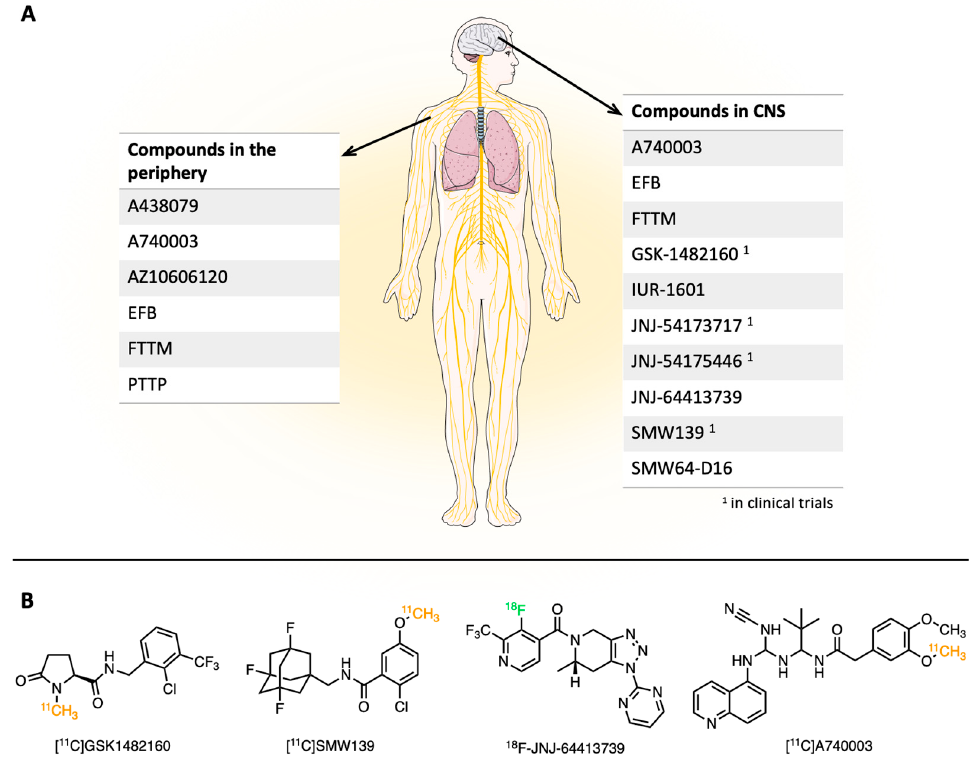
Figure 1. ( A ) Overview of different P2X7R antagonists divided by targeting either the CNS or the peripheral nervous system. ( B ) Common representatives of different structural classes of imaging compounds. Radioisotopes are highlighted with different colors.